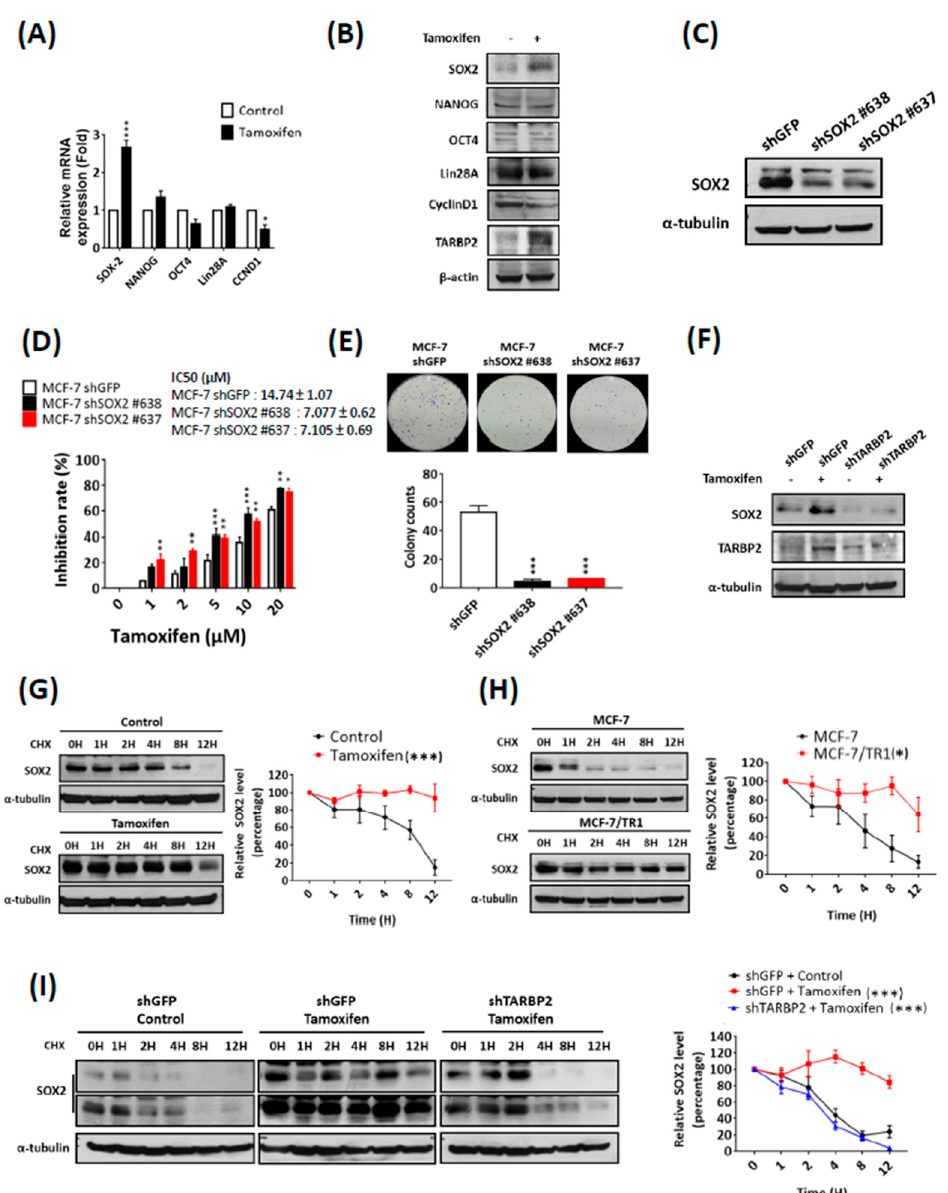
Figure 6. Tamoxifen induces SOX2 to enhance tamoxifen resistance through TARBP2. ( A , B ) Expression of different stem cell markers after tamoxifen treatment. MCF-7 cells were treated with 2 µ M tamoxifen for 48 h and then RNA was isolated to analyze the mRNA expression of stem cell markers by reverse-transcription PCR (qRT-PCR). The experiments were repeated at least 3 times, and ATP5E was used as a positive control for tamoxifen treatment ( A ). * p ≤ 0.05 by t -test. Cells as indicated in ( A ) were collected to analyze protein expression by western blotting ( B ). ( C , D ) Effect of SOX2 expression on tamoxifen sensitivity. MCF-7 cells were transfected with shRNA targeting SOX2 for 48 h and treated with different concentrations of tamoxifen (1, 2, 5, 10, 20 µ M) for 72 h. The efficiency of SOX2 knock-down was examined by western blot ( C ), and the proliferation and colony formation were determined by MTT ( D ) and colony formation assays ( E ), respectively. MTT experimental results are given as the means ± SEM from at least three separate experiments that were performed in duplicate or triplicate and analyzed by two-way ANOVA. * p ≤ 0.05, ** p ≤ 0.01. ( F , G ) Tamoxifen downregulated the protein level of SOX2 through TARBP2. MCF-7 cells were transfected with shRNAs targeting TARBP2 for 48 h; 2 µ M tamoxifen was then added to the culture medium for 48 h. The cells were harvested to determine the protein expressions by western blot. ( G – I ) TARBP2-regulated protein stability of SOX2 in tamoxifen-treated and resistant cells. Tamoxifen-treated (2 µ M for 48 h) MCF-7 ( G ) and MCF-7/TR1 ( H ) cells were treated with 50 μ g/mL cycloheximide to block protein synthesis